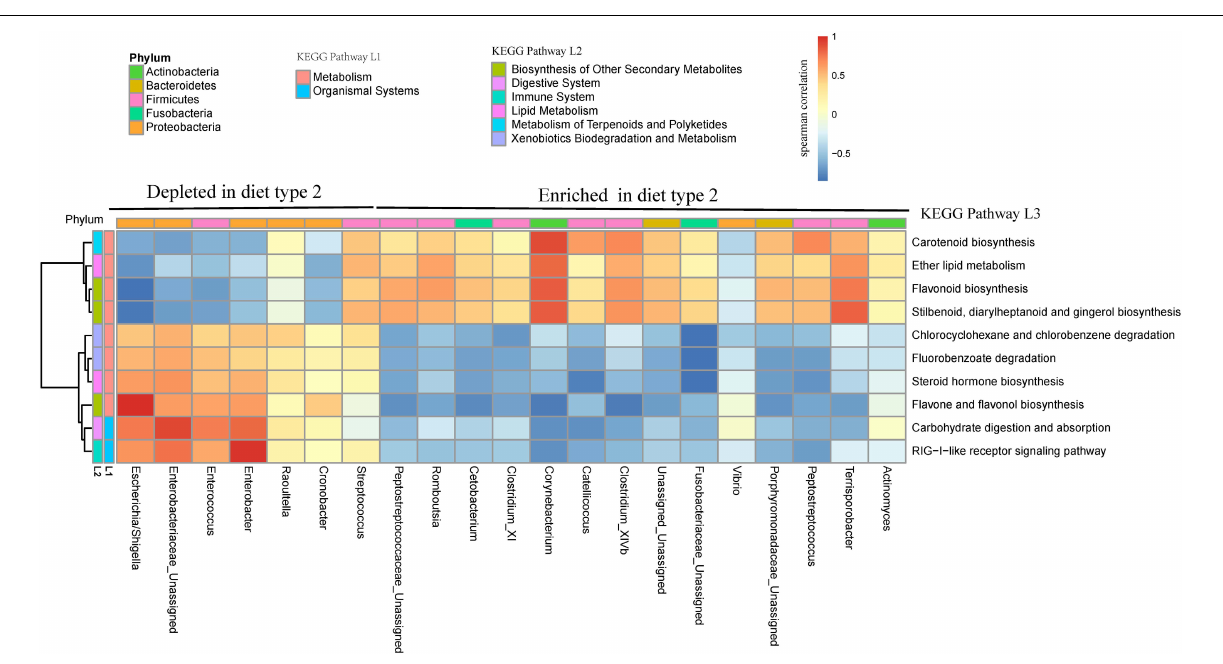
FIGURE 7 | Bacterial taxa from two diet types are related to several KEGG pathways. Gene function of bacteria were predicted using the PICRUST from KEGG annotated databases. Genus and KEGG pathways counts were normalized using edgeR. Spearman’s correlation coefficients were estimated for pairwise comparison between genus abundance and KEGG abundance